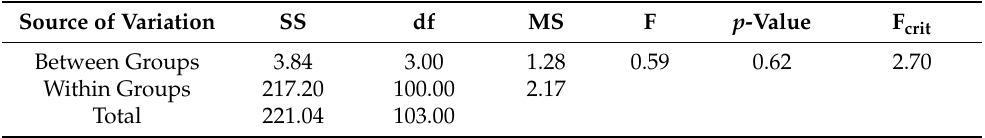
Table 7. ANOVA for BW for the 0.7 mm thick samples welded with and without nitrogen in the shielding